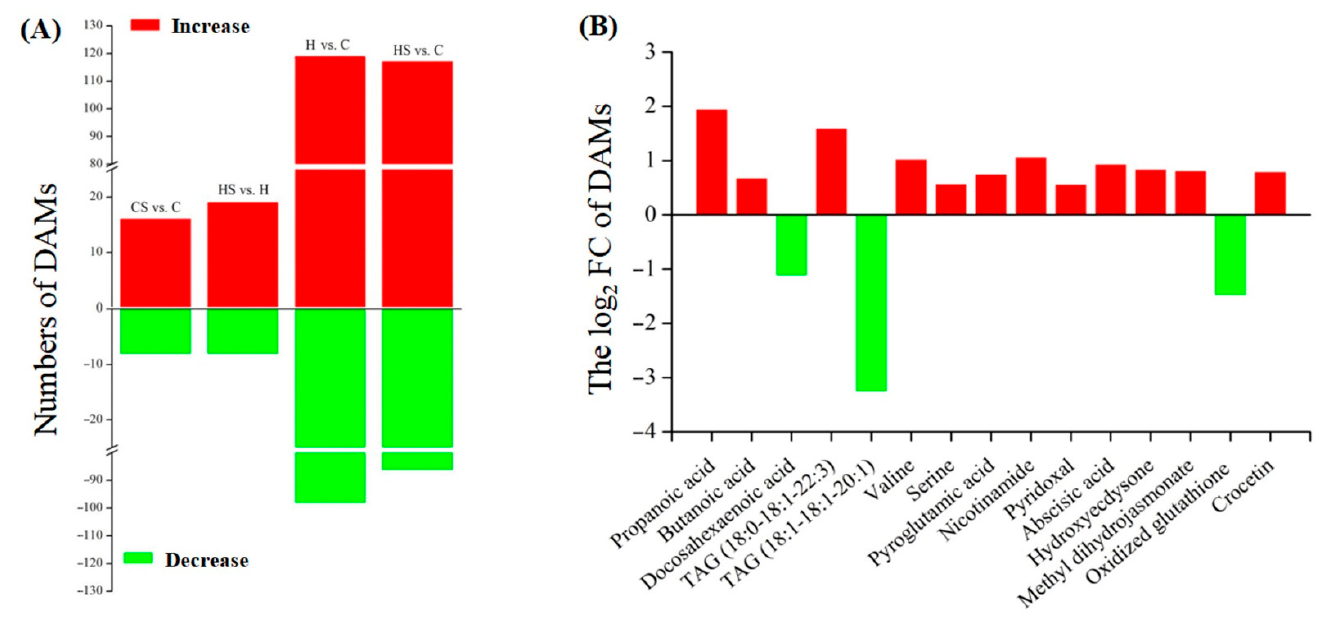
Figure 2. Changes in ( A ) the total numbers of differentially accumulated metabolites (DAMs) in different groups (CS vs. C, HS vs. H, H vs. C, and HS vs. C) and ( B ) key DAMs in the HS vs H. C, control; CS, control + spermidine; H, heat stress; HS, heat stress +